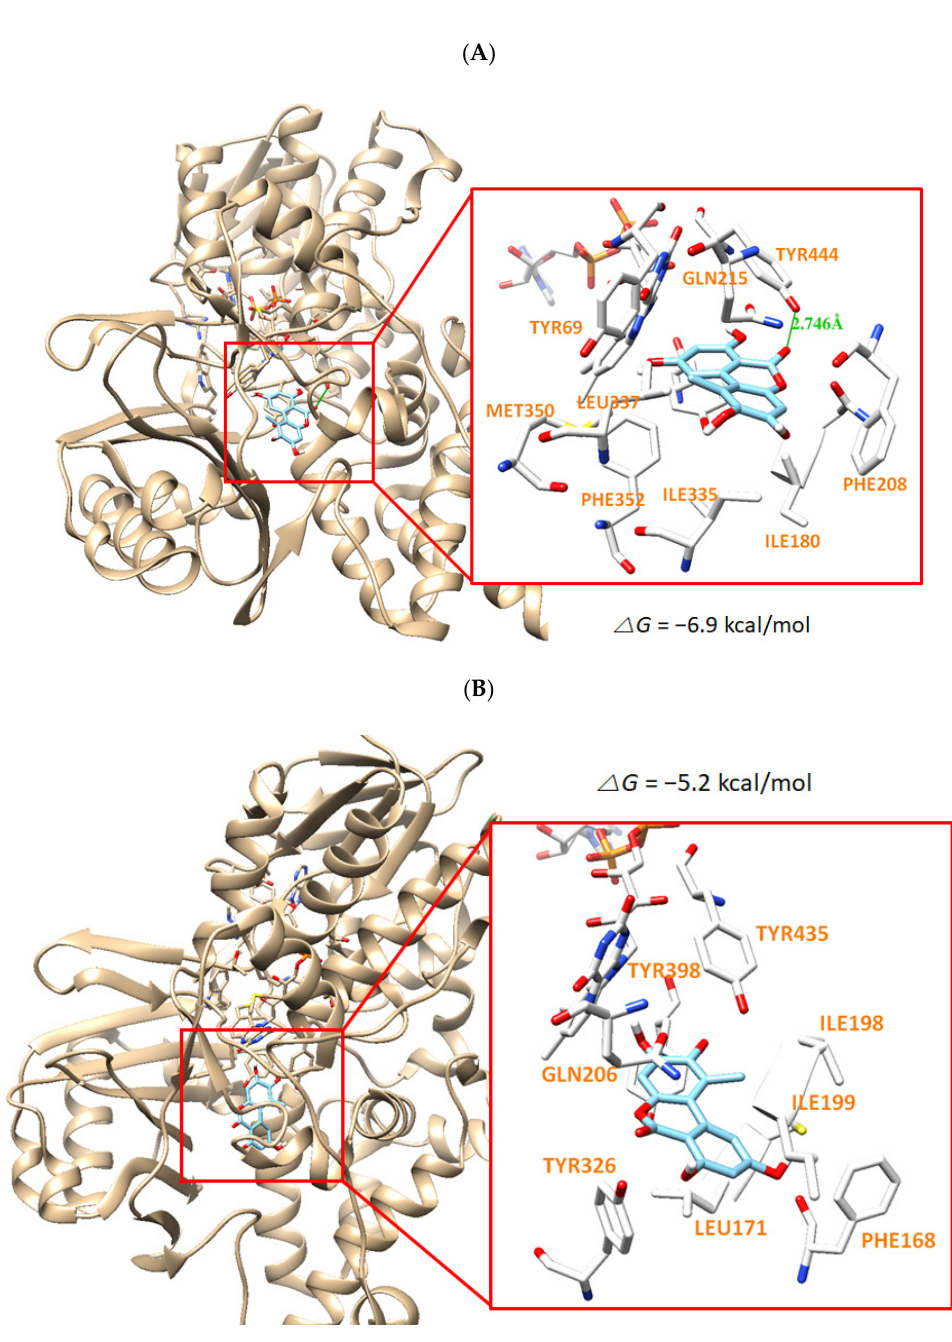
Figure 6. The docking simulation of HAT with hMAO-A (2Z5X) ( A ) and hMAO-B (3PO7) ( B ) as determined by the UCSF Chimera. HAT interacts through a hydrogen bond with Tyr444 residue of hMAO-A at a distance of 2.764 Å.